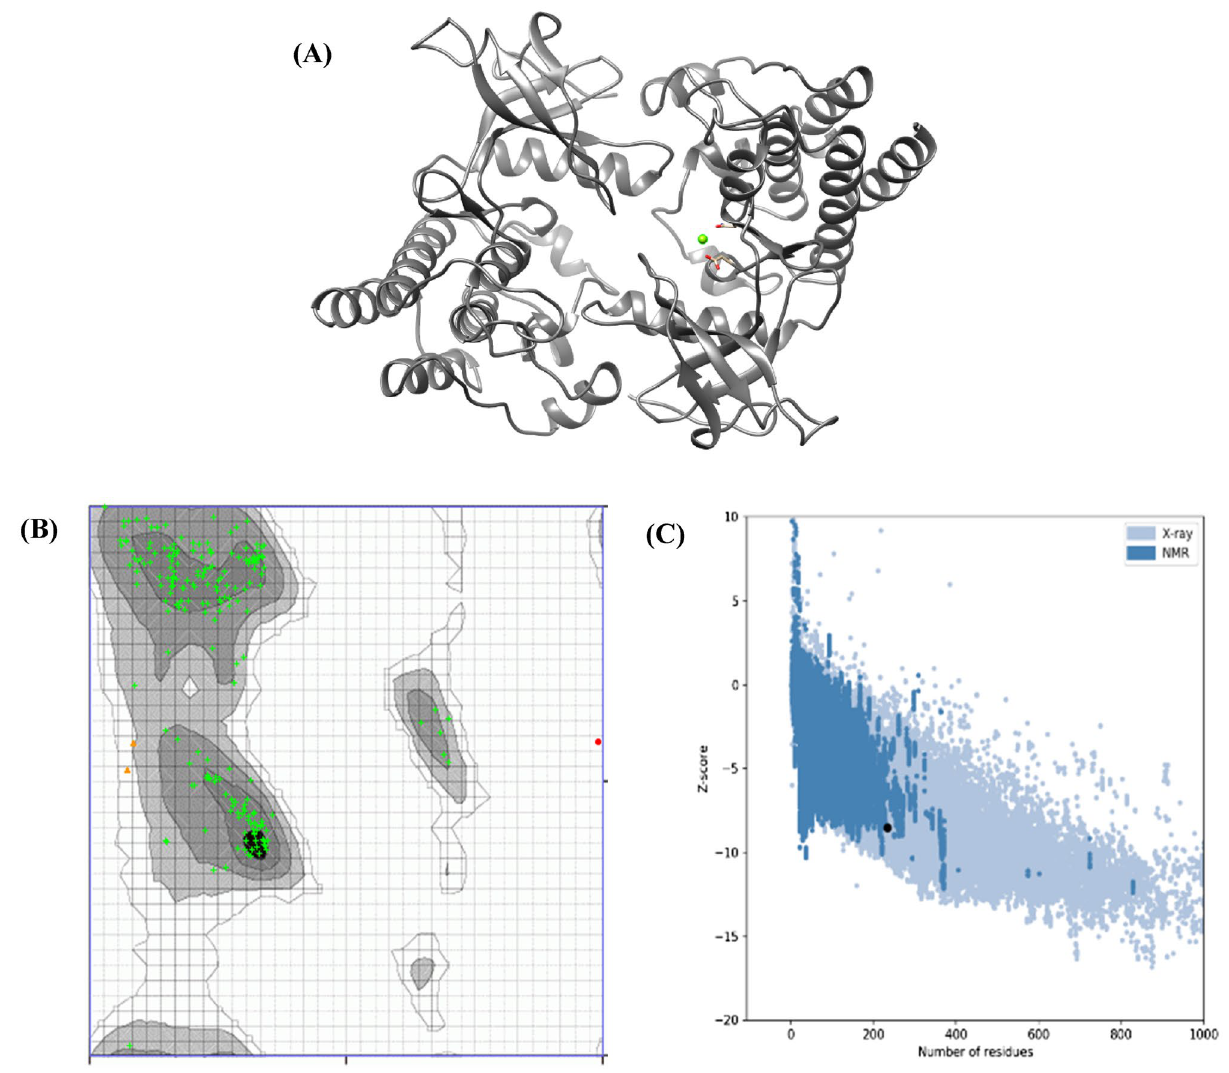
Figure 7. Shows ( A ) GalaxyRefine refined the 3D structure of vaccine construct. ( B ) The refined 3D structure was subjected to a Ramachandran plot analysis showed 98.578% of the residues in favored areas. ( C ) Plot obtained from ProSA-web server.